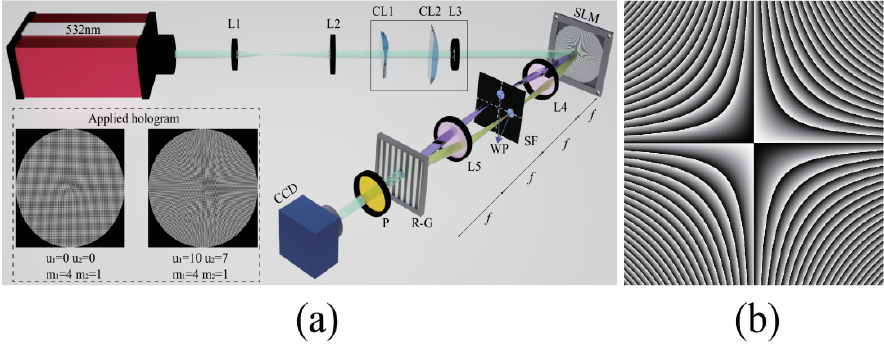
Figure 1. ( a ) The experimental device diagram. L1-L5: lenses; CL1-CL2: cylindrical lens; SF: spatial filter; WP: ( λ /4 or λ /2) wave plate; RG: Ronchi grating; P: polarizer; CCD: Charged-coupled device camera. ( b ) A twisted phase distribution uxy with u = 10 mm − 2 ; here, the size of the plot is 6.9 × 6.9 mm 2